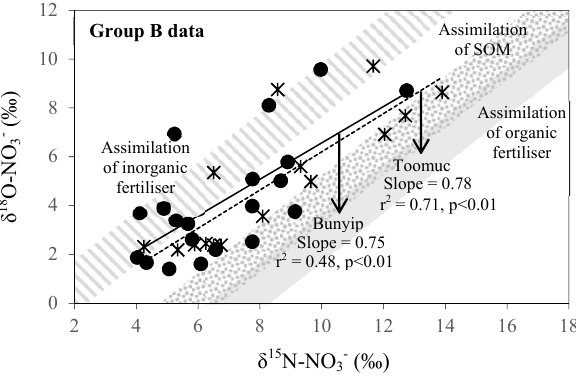
Figure 9. Biplot of δ 15 N–NO − Toomuc (group B data in Fig. 8b). Shaded areas represent theo- retical assimilation trends for cow manure, SOM and inorganic fer- tiliser. The maximum and minimum starting values for δ 18 O–NO − were estimated from Eq. (1). The starting δ 15 N–NO − TN value of respective end member. Solid and dotted lines represent the assimilation trends for Bunyip (both lower and upper Bunyip) and Toomuc, respectively. Assimilation rather than denitrification was considered a more plausible process controlling the distribu- Figure 8. Biplot of δ 15 N–NO − vs. δ 18 O–NO − for (a) wet and 3 3 tion pattern for the group B dataset as the water column was oxic (b) dry periods. The blue shaded area represents possible iso- throughout the study topic compositions of denitrified NO − originated from SOM ( δ 15 N: 3 + 4 . 5‰). The grey shaded area represents the possible isotopic composition of denitrified NO − originated from inorganic fer- 3 tiliser ( δ 15 N–NO − : + 0 . 1‰). The δ 18 O–NO − used were − 2 . 3 and 3 3 ± 0.23‰ representing the minimum and maximum estimates of δ 18 O of nitrified NO − , respectively. The shaded areas were plotted 3 based on the theoretical 1:1 and 2:1 denitrification relationships between δ 15 N–NO − and δ 18 O–NO − (Kendall et al., 2007). 3 3